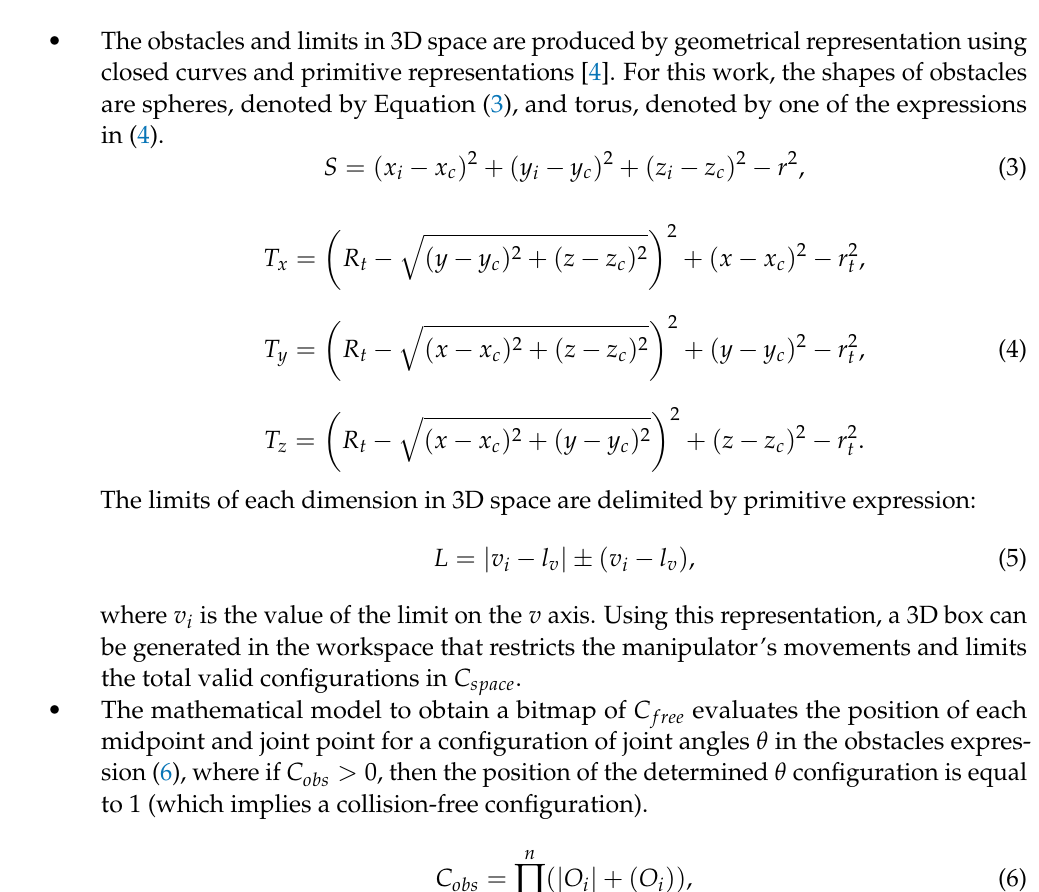
Figure 6. Midpoints and guard distance of